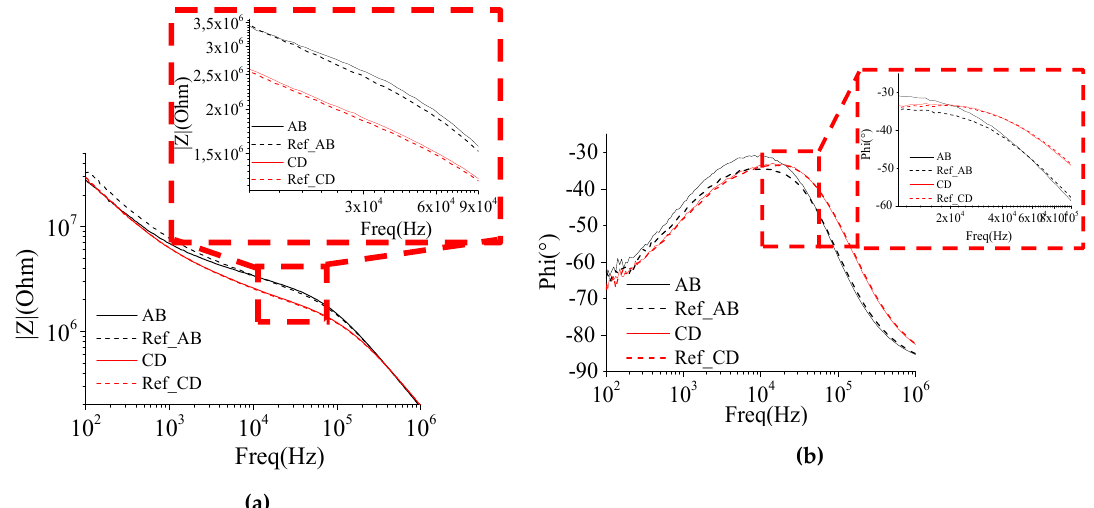
Figure 16. ( a ) The impedance spectrum and ( b ) the phase of the measurements between electrodes A and B (black) and between electrodes C and D (magenta).